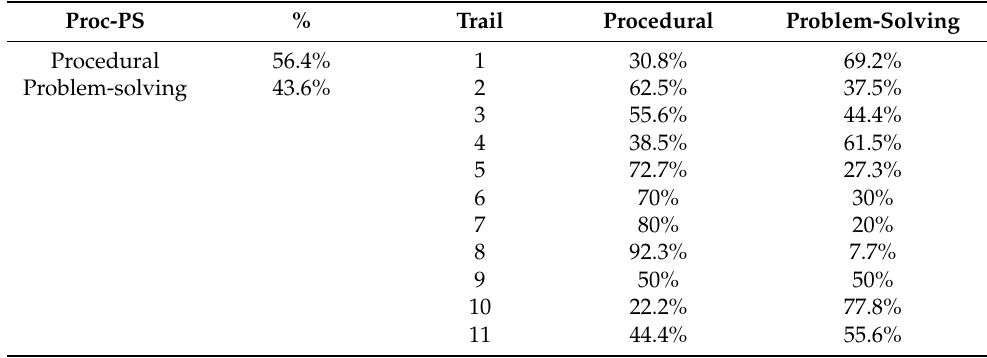
Table 5. Procedural vs. problem-solving tasks ( Proc-PS ) and breakdown for each